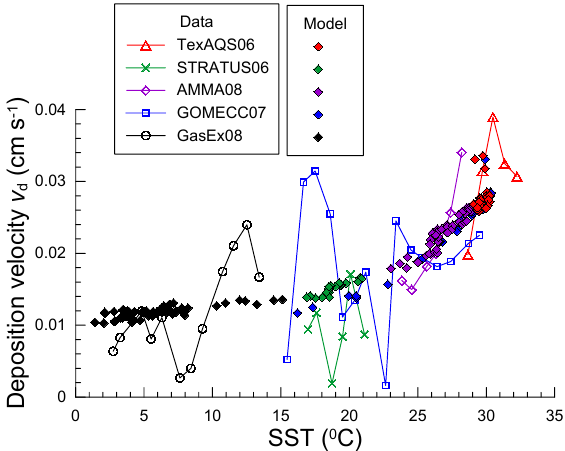
Figure 7. Ozone dry deposition velocity ( v d ) as a function of sea surface temperature (SST) from five field experiments (Helmig et al., 2012; Ludovic Bariteau, personal communication, 2016) and the corresponding values obtained from the ACCESS-UKCA model using the new two-layer scheme (Eq. 16) for ozone deposition to the